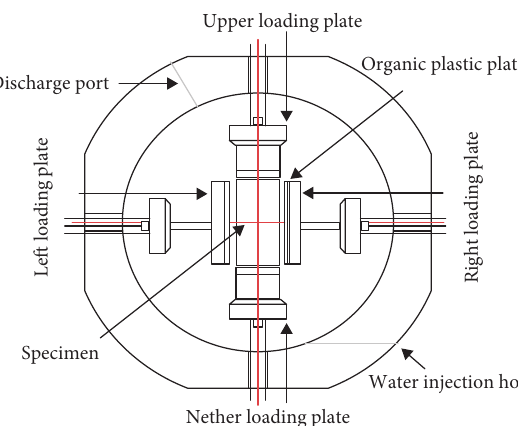
Figure 2: Diagram of true-triaxial pressure chamber.